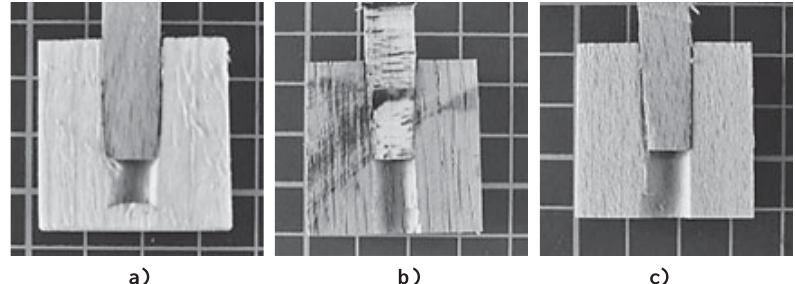
Figure 2 Cross-section of the dowel welded parallel to the fi bre orientation for: a) spruce; b) oak; c)